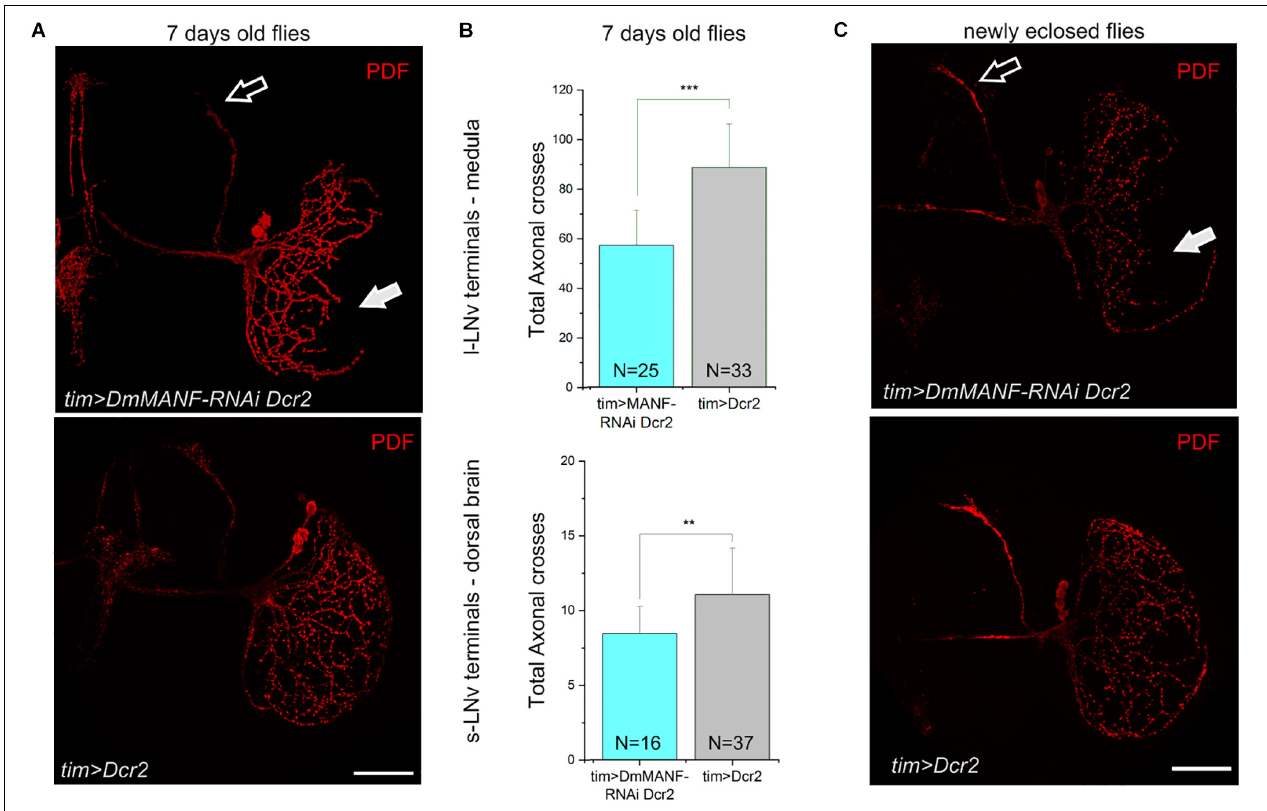
FIGURE 4 | Reduced DmMANF expression affects the morphology of the PDF-positive cells. (A) PDF immunostaining of the projections of the s-LNvs in the dorsal brain (open arrow) and of the l-LNvs in the medulla (solid arrow). Flies with reduced DmMANF expression ( tim > DmMANF-RNAi Dcr2 ) are compared to control ( tim > Dcr2 ). (B) Sholl analysis shows reduced total axonal crosses in tim > DmMANF-RNAi Dcr2 flies compared to tim > Dcr2 flies. This is true for both l-LNvs (56.75 ± 14.29 vs . 88.22 ± 17.72; t -test: p < 0.001) and s-LNvs (8.44 ± 1.8 vs . 11.03 ± 3.1, Mann-Whitney Test: p = 0.0015). N represents the number of individuals used for each analysis. (C) The same morphological changes are observed in newly eclosed flies (few hours after eclosion). Scale bars: 50 µ